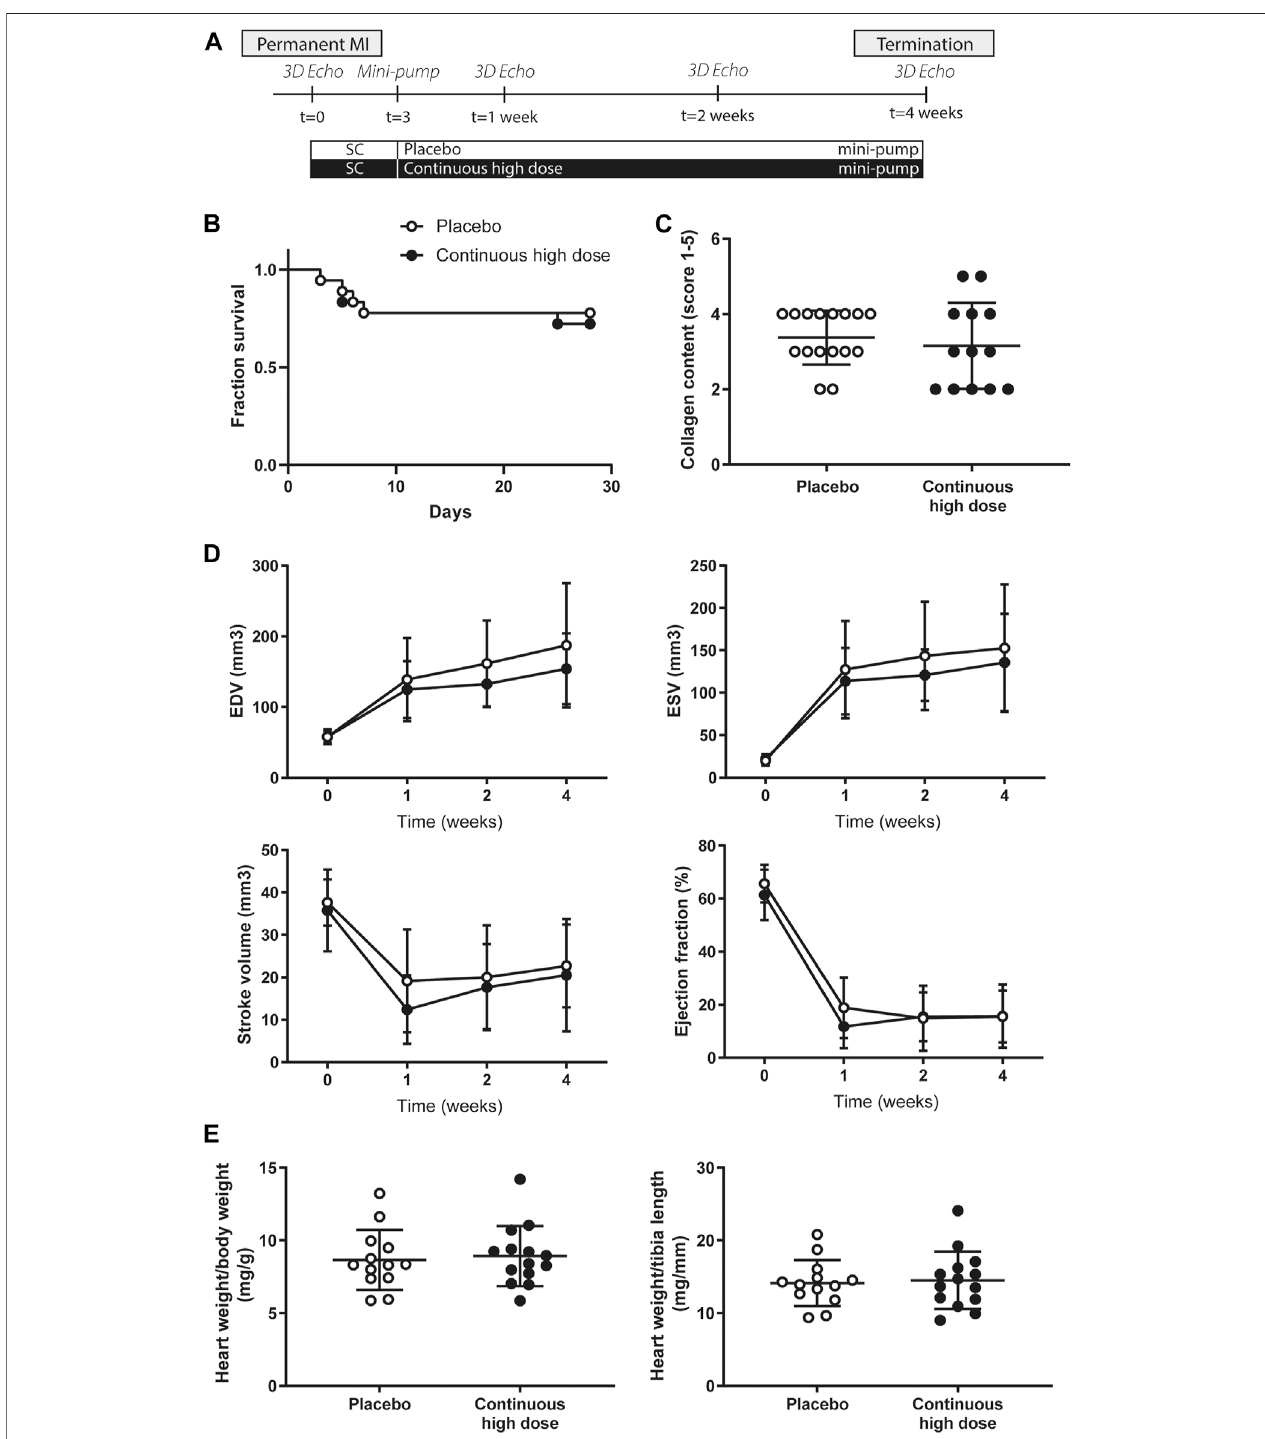
FIGURE 3| Study design, survival, global cardiac function and cardiac hypertrophy assessment in mice after permanent myocardial infarction. (A) Overview of the micestudy. (B) Fractionofsurvivalofplaceboandcontinuoushighdosetreatedanimalsovertheentirefollow-up.MI,myocardialinfarction. (C) Quanti fi cationofcollagen content score (1: no collagen — 5: extensive collagen) showed no differences in interstitial fi brosis between placebo and continuous high dose treated animals. (D) End- systolicvolume(ESV),end-diastolicvolume(EDV),strokevolume(SV),andejectionfraction(EF)measuredby3Dechocardiographyatbaseline,7,14,and28 days after permanent ligation. No signi fi cant differences were observed between the different experimental groups. (E) Heart weight/body weight ratio (mg/g) and heart weight/tibia length (mg/mm) between groups were similar 28 days after permanent ligation.